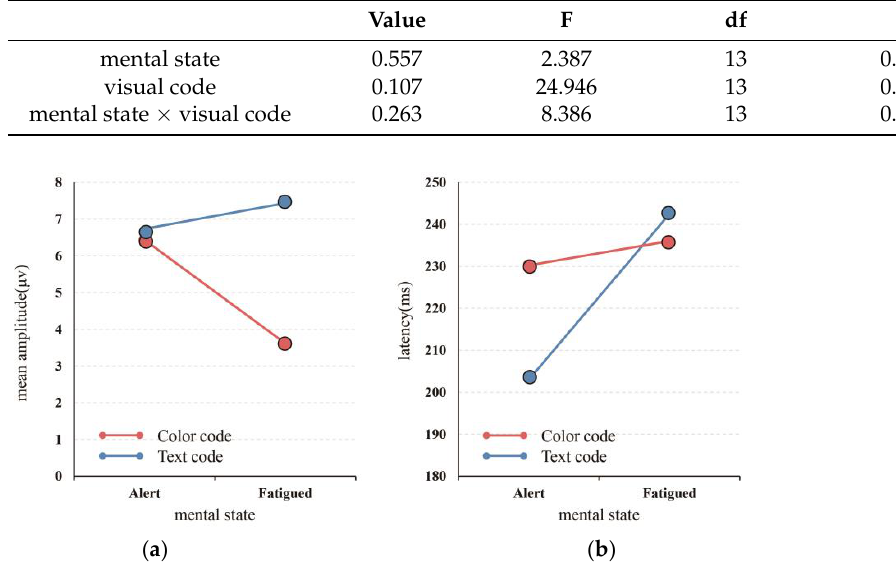
Figure 9. ( a ) Mean amplitude of mental state × visual code. ( b ) Latency of mental state × visual code